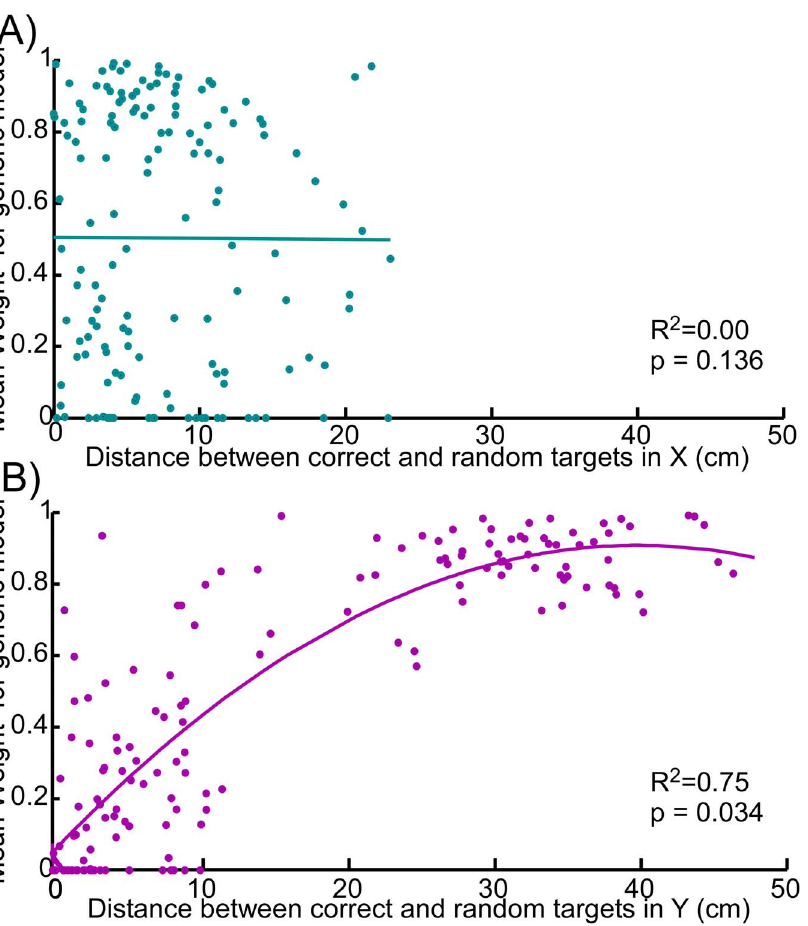
Figure 7. The mean weight assigned to the generic model for each reach where only the random target was in the mixture, plotted against the error between the target location and the random target used by the decoder in A) X with linear fit; and B) Y with quadratic fit. Regression functions are shown with corresponding R 2 and p statistics.